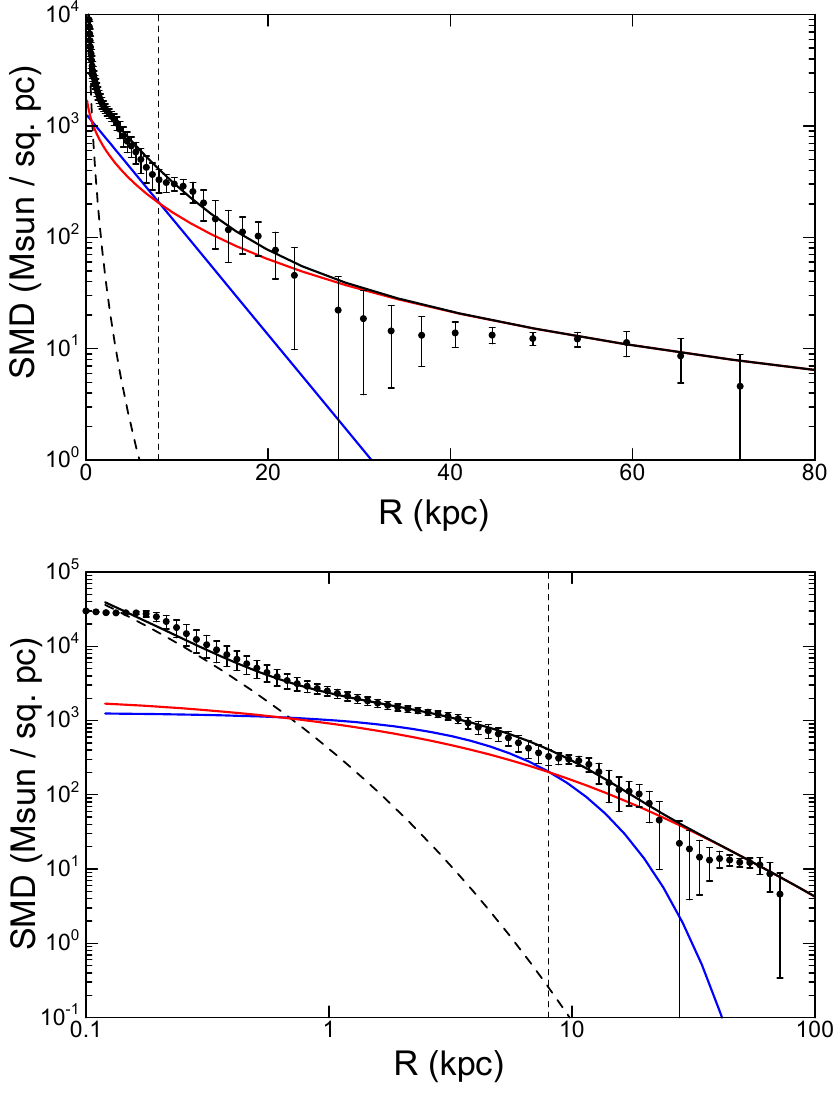
Figure 3. ( Top ) Direct surface-mass density (SMD) calculated for the unified RC in Figure 1 in spherical symmetry assumption (dots with error bars) in semi-logarithmic representation. The solid line is the χ 2 fit, and red, blue, and dashed lines represent the NFW halo, disk, and bulge, respectively. ( Bottom ) Same, but in log–log plots. The semi-logarithmic plot makes it easier to discriminate the dark halo from exponential disk, which appears as a straight line. The plotted values are listed in the tables in Appendix